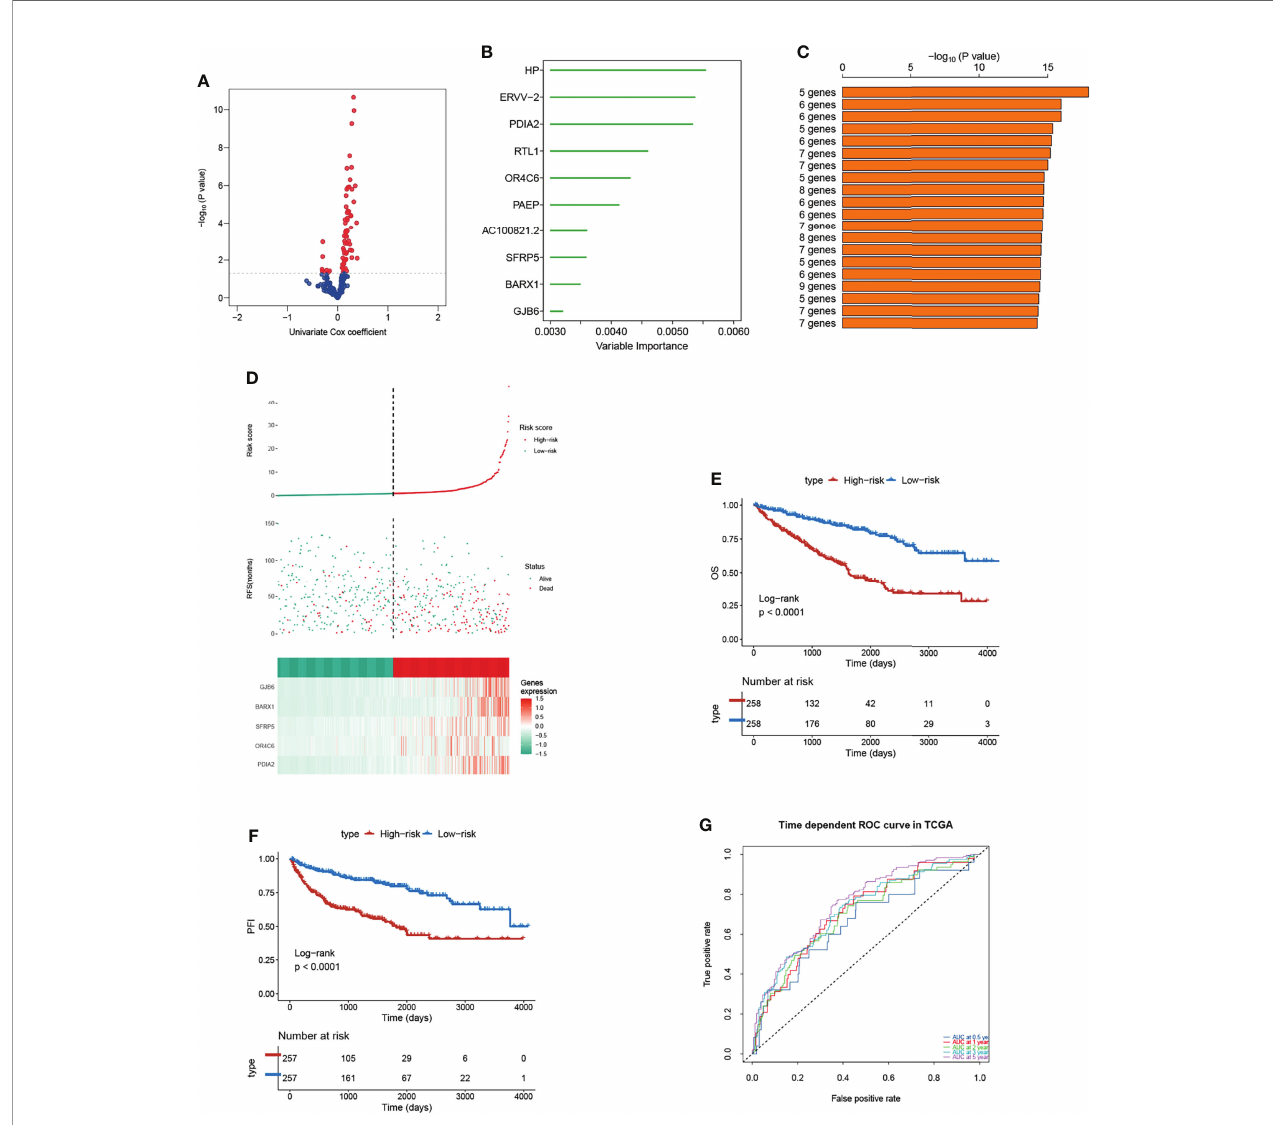
FIGURE 7 | Construction of m7Sig and validation. (A) Volcano plot illustrating the m 7 G subtype-based genes by Univariable Cox Regression analysis. (B) Random survival forest analysis screening 10 genes. (C) After Kaplan – Meier analysis of various combinations, the top 20 signatures are ordered by the p-value. The fi ve-gene signature was established, for it had a relatively great − log 10 (p value). (D) m7Sig risk score analysis of patients in TCGA-ccRCC cohort. (E, F) Kaplan-Meier analysis for OS (left) and PFI (right) of the high- and low-risk subtypes in TCGA-ccRCC cohort. (G) The time-dependent ROC curves analysis for m7Sig in TCGA-ccRCC